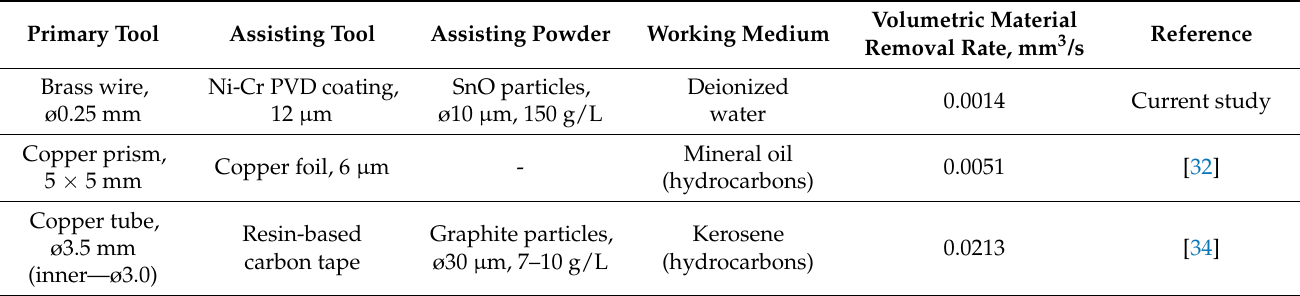
Table 14. Calculated enthalpy of formation of some Ni-containing substances.